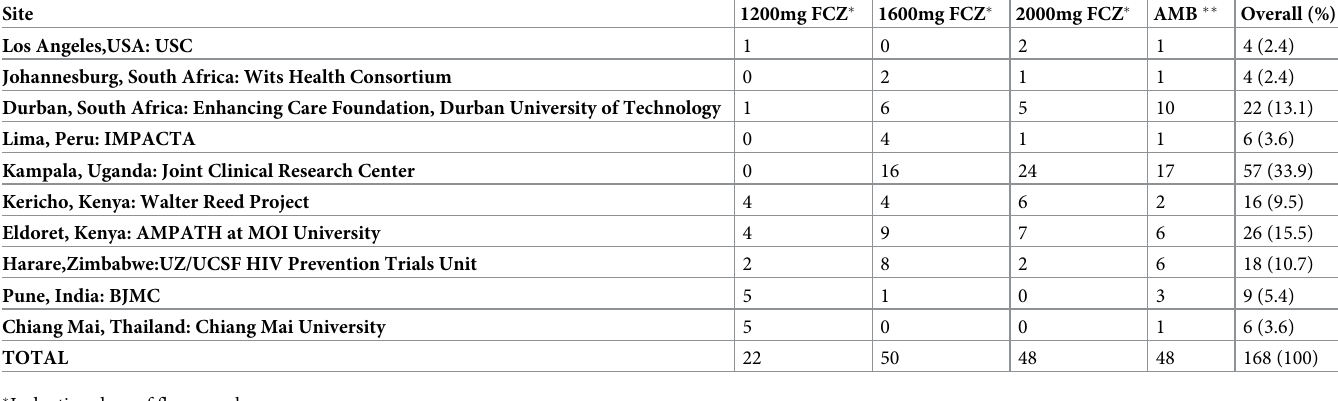
Table 1. Accrual of participants by induction dose and ACTG sites.